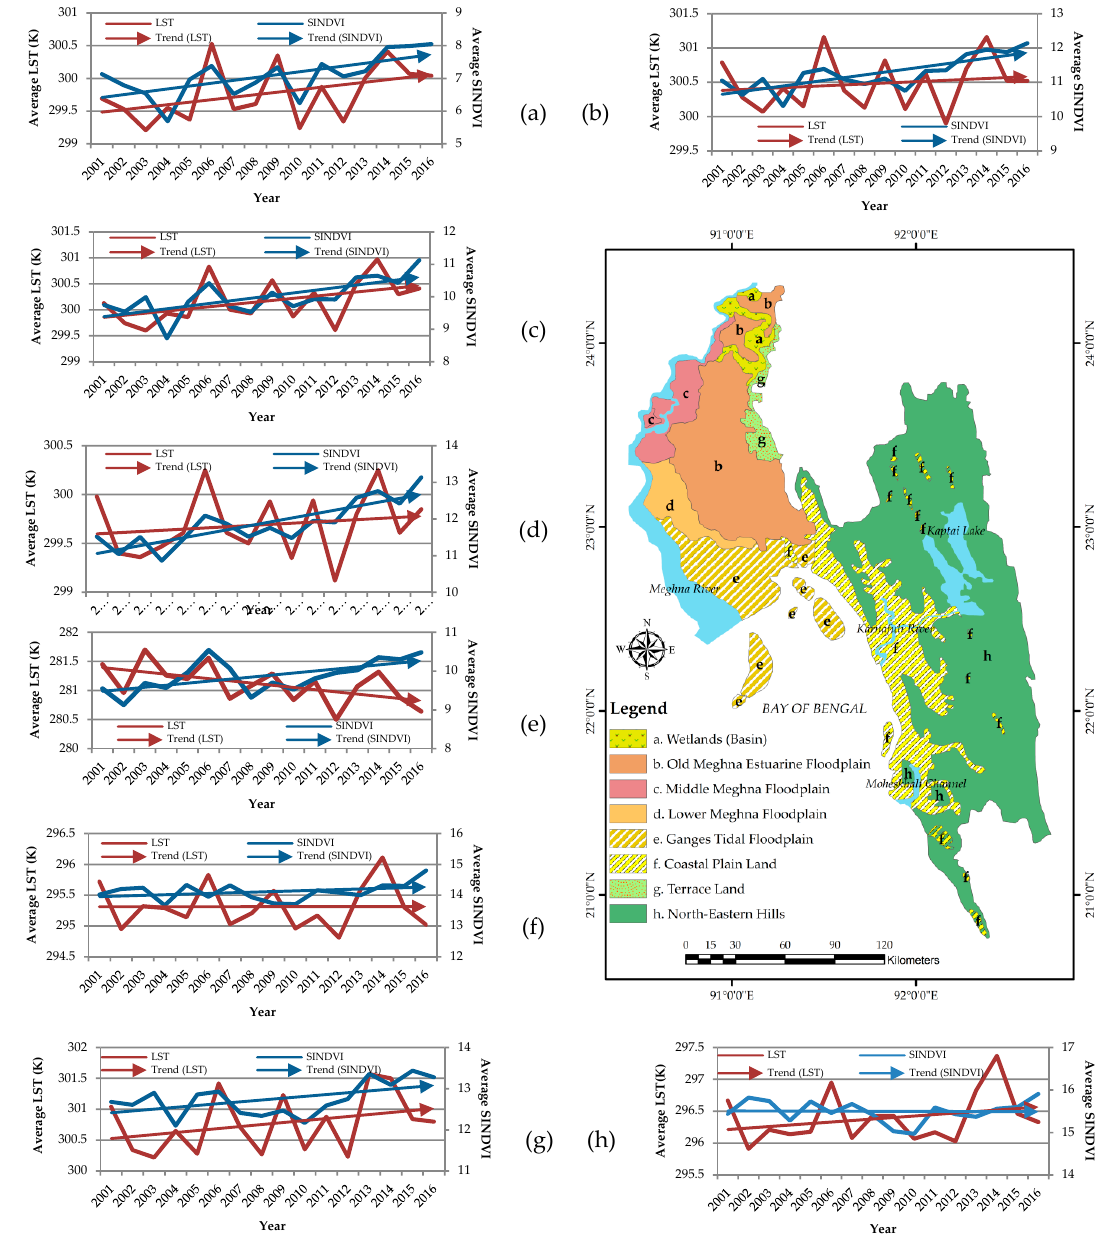
Figure 9. Interannual averages of LST and SINDVI in ( a ) wetlands, ( b ) old Meghna estuarine floodplain, ( c ) middle Meghna River floodplain, ( d ) lower Meghna River floodplain, ( e ) Ganges tidal floodplain, ( f ) coastal plain lands, ( g ) terraced lands, and ( h ) Northeastern Hills at the southeastern region of Bangladesh. In the areas of tidal floodplains, coastal plain lands, and Northeastern Hills, the interannual relations were quite inversed (Figure 9e,f,h). The decreasing years of LST at the tidal floodplain areas have increased the SINDVI in high proportions. Although the land surface temperatures were mostly static at the coastal plain lands, the yearly average SINDVIs have fluctuated and increased. The hilly and mountain lands vegetation dynamism was mostly static with a little fluctuating in the interannual index, although it showed increasing temperatures. The entire indexes of the LST were found to have increasing trends overall land types except tidal floodplains and coastal plain lands in the southeastern region of Bangladesh during the period of study (Figure 10). These increased temperatures acted as mostly positive consequences on vegetation dynamics for the plain land areas as well negative for hilly and mountainous region. Figure 10. Geospatial relations of LST and SINDVI range by mean value average. The middle Meghna River floodplain region experienced the highest increase in temperature (0.6 ℃ /16years ) and a moderate SINDVI increase (1.3 indexed). The highest vegetation increase (1.5 indexed) was in the lower Meghna floodplain with only 0.2 ℃ /16 years increase in temperatures. The hilly and mountain regions lost 0.1 indexed value of SINDVI for 0.3 ℃ /16years temperature increase. The decreasing and mostly static temperature changes in the study areas acted to increase vegetation dynamics. The tidal floodplain region received a 0.8 indexed value of SINDVI for 0.6 ℃ /16years temperature decrease, and coastal plain land received 0.4 indexed value of SINDVI for its stable temperatures.